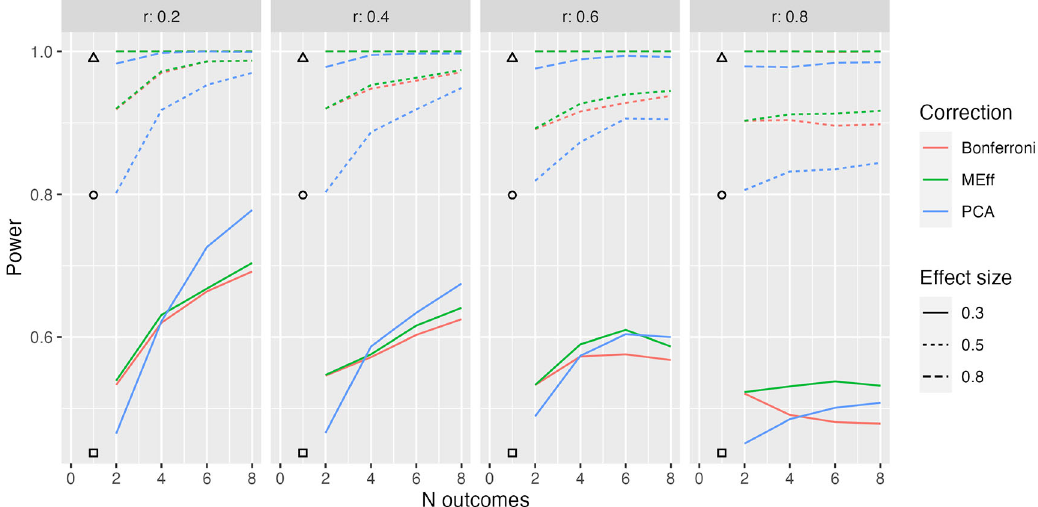
Figure 3.ModelL2: 50pergroup. Powerinrelation tonumber ofoutcomemeasures (Noutcomes),intercorrelation between outcomes (column headers), type of Correction, and Effect size. The square, circle and triangle symbols represent the power for a single outcome measure with effect size .3, .5 and .8